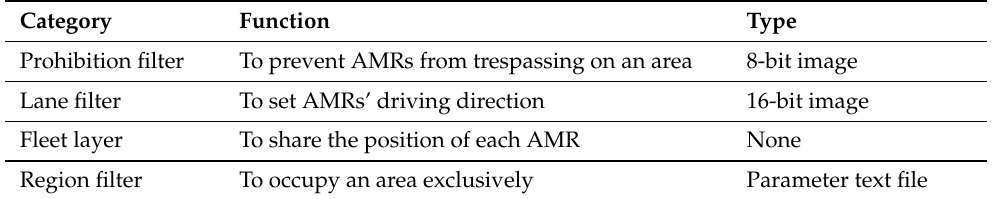
Table 1. Summary of filters and a layer.